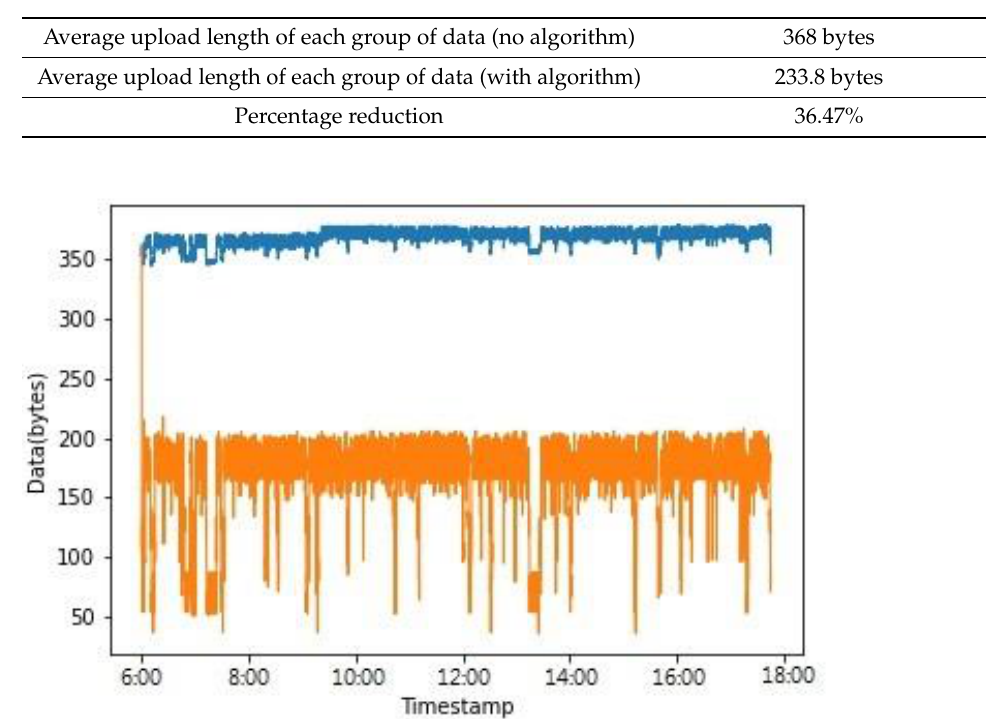
Figure 8. Reduce the length of uploaded data (using only Method I). Table 1. Average length of data (using only Method I). Table 1. Average length of data (using only Method I).